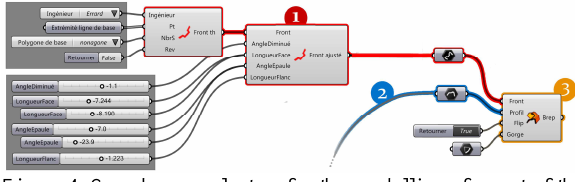
Figure 4. Grasshopper clusters for the modelling of a part of the city wall. In the far left, several parameters (angle and length values) of the city wall front line (1) have been adjusted before the resulting line is linked in conjunction with a profile (2) as a parameter of the sweeping component